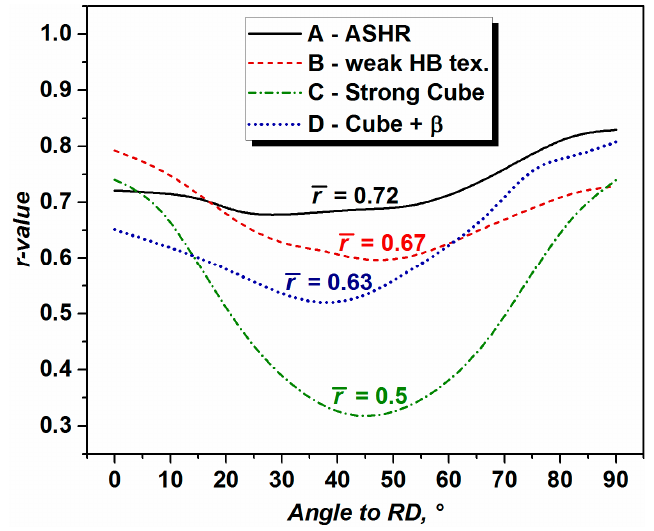
Figure 7. Calculated Lankford profiles for investigated materials A–D based on recrystallization textures presented in Figure 5. The legend briefly summarizes the HB textures (ASHR stands for the asymmetrically hot rolled sample with a non-symmetric